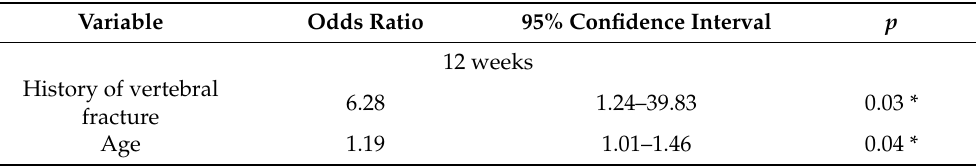
Table 4. Multiple logistic regression analysis: independent risk factors of residual low back pain (VAS ≥ 3.5 at final